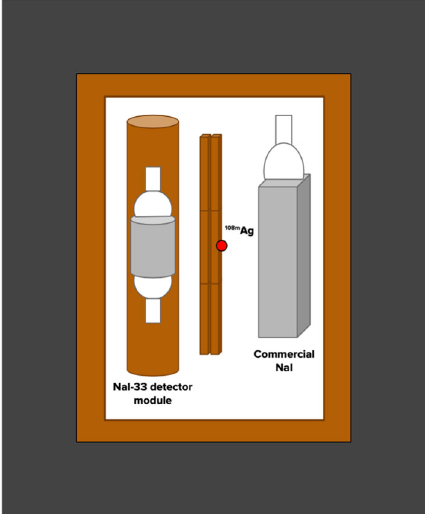
Fig. 7 Schematic view of the experimental setup used for the 108m Ag source campaign. It is shown the passive shielding of lead and copper, with the NaI-33 detector module and the commercial NaI detector. γ rays emitted from the 108m Ag source, identified by a red circle, are degraded via a copper